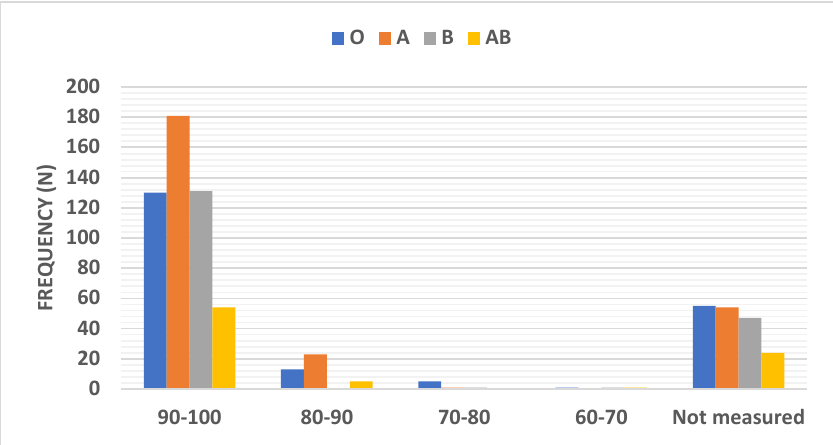
Figure 5. Among the different blood groups, blood group A showed the highest percent- age of patients (70.2%) who experienced an oxygen saturation in the range of 90–100% (standardized residuals of 1.95 and Bonferroni corrected p -value = 0.05). The blood group B showed the lowest percentage of patients (0%) who experienced an oxygen saturation range of 80–90% (standardized residuals of 3.16 and Bonferroni corrected p -value = 0.0015). In addition, the blood group O showed the highest percentage of patients (1.8%) who experienced an oxygen saturation range of 70%-80% (standardized residuals of 2.24 and Bonferroni corrected p -value = 0.025).